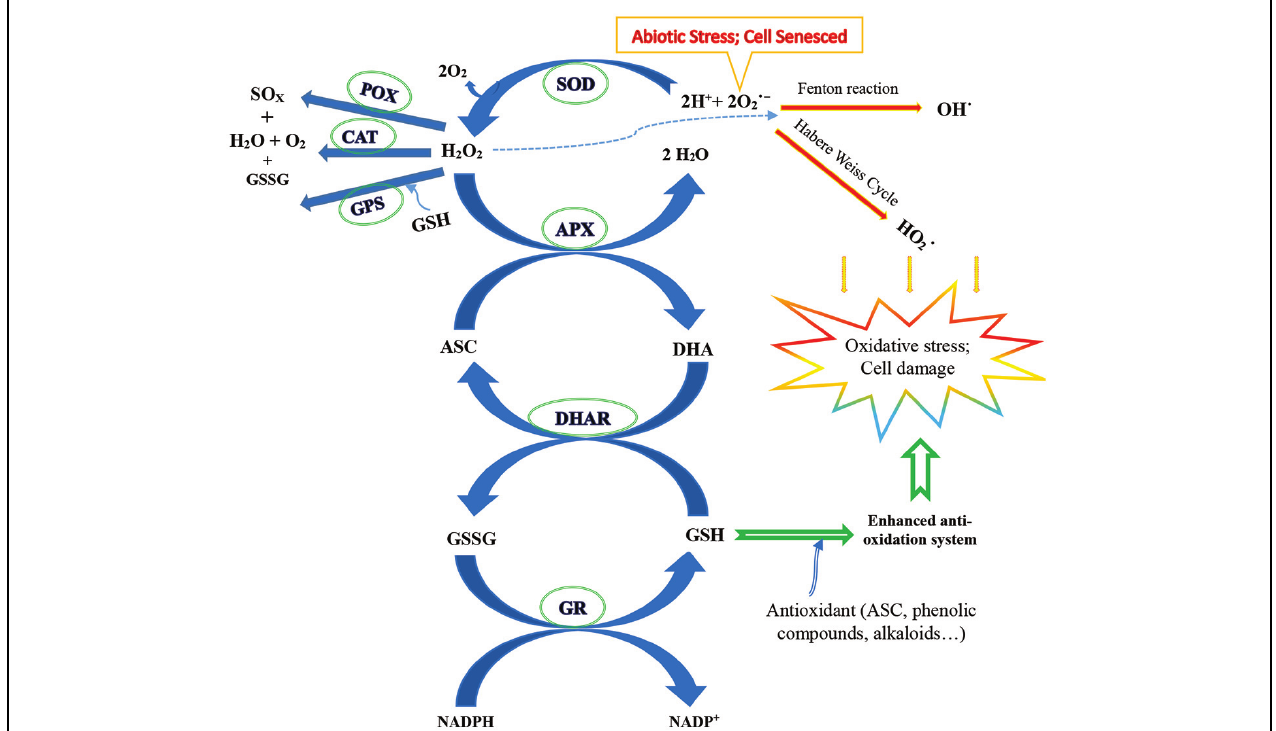
FIGURE 2 | A diagrammatic outline of the antioxidant defense systems and the responses to elevated CO 2 with abiotic stress. Elevated CO 2 may alleviate the damage of oxidative stress from abiotic stress factors, such as heat, drought, and ozone, by ameliorating the antioxidant defense systems of non-enzymatic compounds, potentially including ascorbate (ASC), glutathione (GSH), phenolic compounds, and alkaloids, and the relevant enzymes, possibly including superoxide dismutase (SOD), ascorbate peroxidase (APX), dehydroascorbate reductase (DHAR), glutathione reductase (GR), peroxidase (POX), catalase (CAT), and glutathione peroxidase (GPX). ROSs, including superoxide radicals (O ·− 2 ), hydrogen peroxide (H 2 O 2 ), hydroxyl radicals (OH · ), and perhydroxy radicals (HO · 2 ), accumulate when plants undergo abiotic stress or are senesced by the Fenton reaction and/or the Habere Weiss mechanism (Hodges and Forney, 2000; Gill and Tuteja, 2010). Whether the rising CO 2 mitigates oxidative damage and the response magnitude, and which parts play major roles, depends on the plant species, crop varieties, developmental stage, abiotic factors, and their combinations (e.g., Hodges and Forney, 2000; Gill and Tuteja, 2010; Abd Elgawad and Asard, 2013; Kumari et al., 2013; Zinta et al., 2014). GSSG, oxidized glutathione; DHA, dehydroascorbate. This diagram is based mainly on the studies by Gill and Tuteja (2010) and Zinta et al.